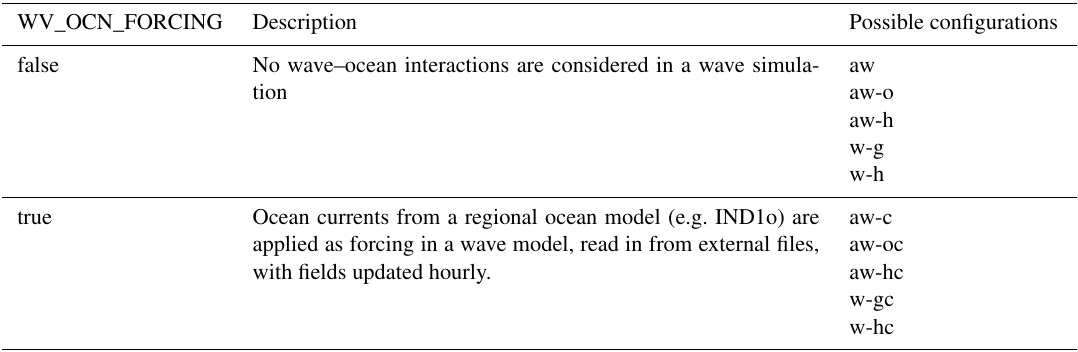
Table 6. Summary of the uncoupled ocean forcing options available when running wave model configurations within the RCS modelling framework, applicable for model configurations in which there is no dynamic coupling to a regional ocean model. Options are controlled using the WV_OCN_FORCING environment variable.